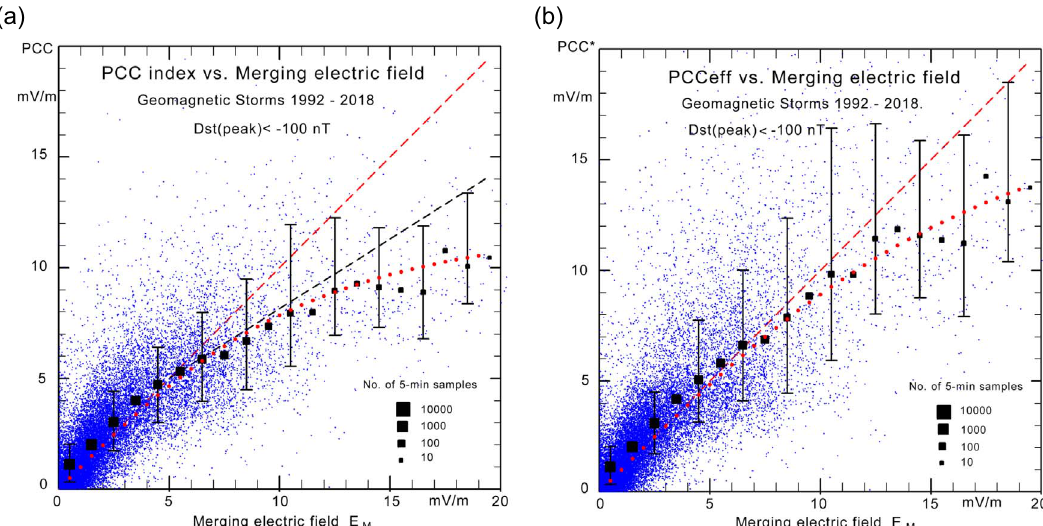
Fig. 13. (a) Relations between the merging electric fi eld, E M , and the polar cap, PCC, index. The small blue dots display the individual 15-min samples. The larger black squares with error bars show the bin-average values and sample numbers. The dashed red line indicates equality while the red dots display a functional relation between E M and PCC. The dashed black line indicates a PCC modi fi cation (b) Same data set but with the modi fi ed PCC values (PCCeff) displayed against E M .